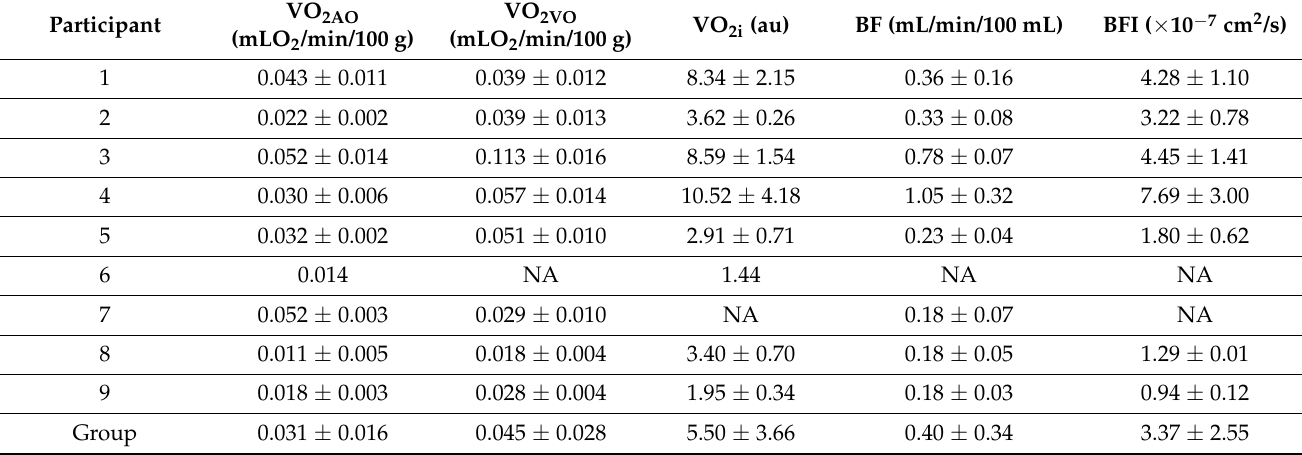
Table 2. Resting-state oxygen metabolism and blood flow. Mean ± standard deviation oxygen metabolism measured during arterial occlusion and venous occlusion (VO 2AO and VO 2VO , respectively), as well as oxygen metabolism index averaged prior to the arterial occlusion (VO 2i , in units of cm 2 /s × mL O 2 /g × 10 − 8 ), blood flow measured during venous occlusion (BF), and blood flow index (BFI, in units of cm 2 /s × 10 − 7 ) across 5 repetitions. NA denotes data not available. Participant 6 only completed 1 arterial occlusion, and therefore no VO 2VO , BF, or BFI values; participant 7 had no DCS data and therefore no VO 2i or BFI values. VO 2AO , VO 2VO , VO 2i , and BF data are reported for the 3.5 cm source-detector separation.